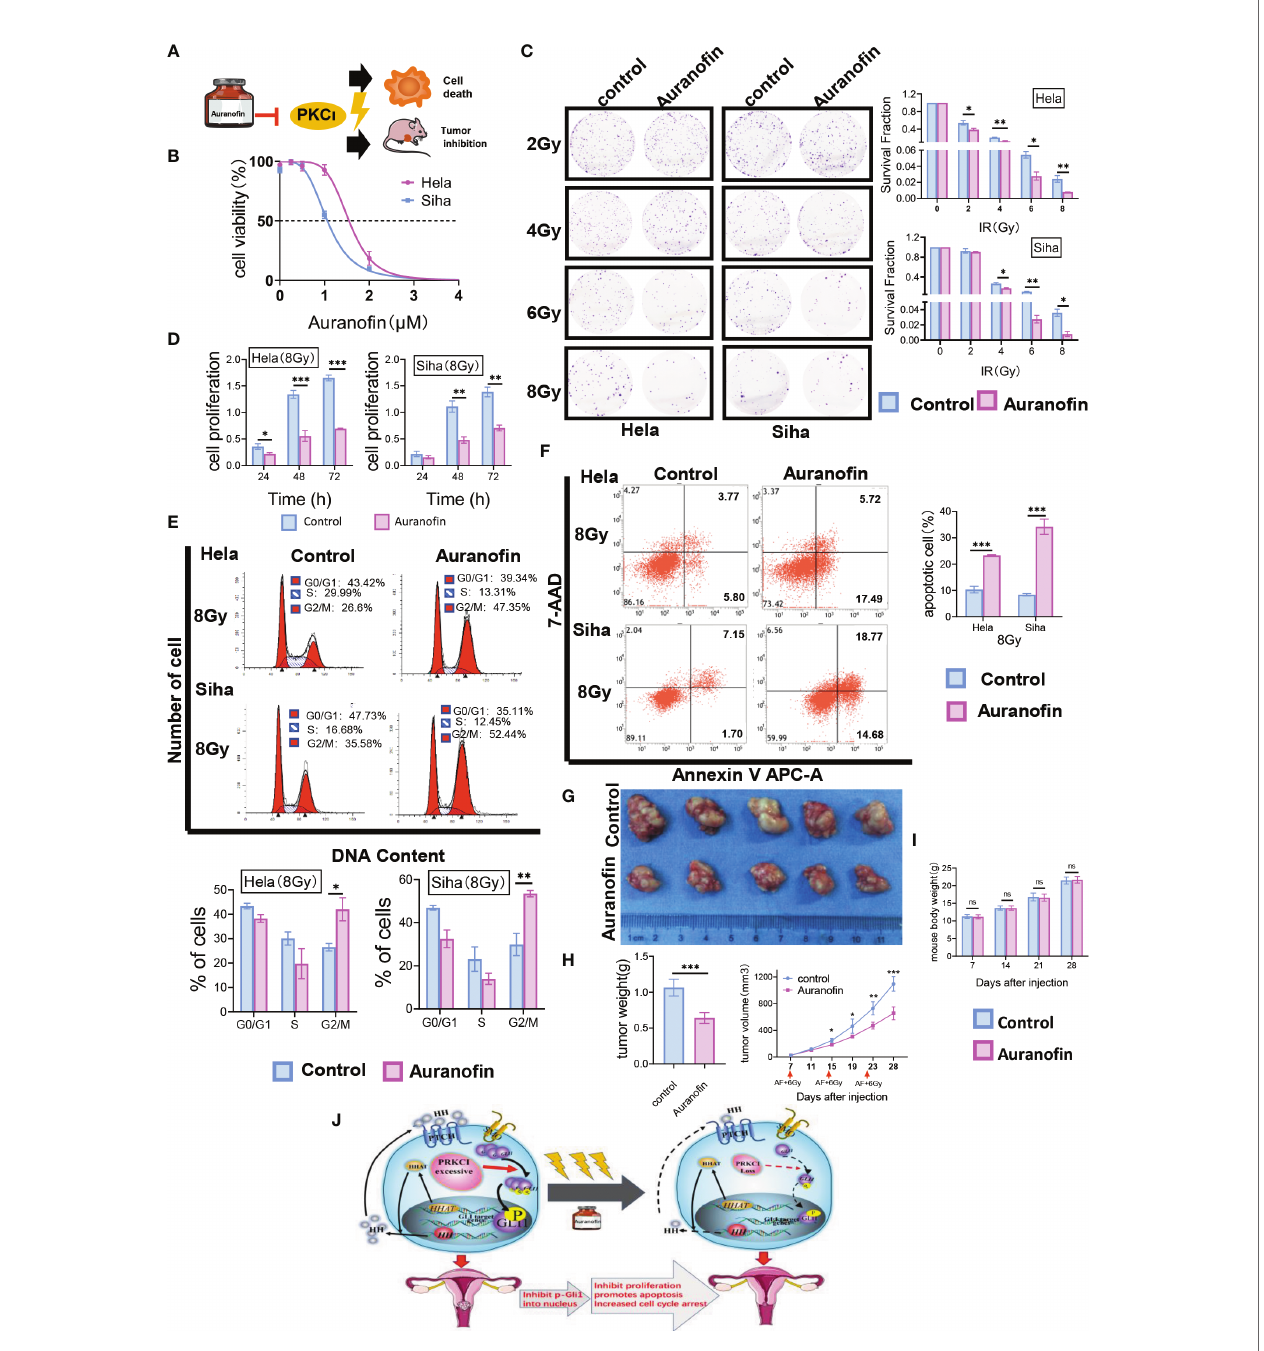
FIGURE 7 | AF, a selective inhibitor of PKC i , affected radiosensitivity in CC cells in vitro and in vivo . (A) Work fl ow for AF-mediated radiosensitivity of CC in vitro and in vivo . (B) Representative IC50 curves calculated for AF in HeLa and SiHa cells are shown. (C) In colony formation assays, AF affected the proliferation of HeLa and SiHa cells treated with radiotherapy in a dose-dependent manner. (D) The cell viability of AF-treated HeLa and SiHa cells after radiotherapy at 8 Gy by CCK-8 assays. (E) AF-induced G2/M- phase cell cycle arrest with radiotherapy. (F) AF increased apoptosis of HeLa and SiHa cells treated with radiotherapy. (G) Nude mouse models were treated by intraperitoneal injection with AF or 0.1% DMSO before irradiation. (H) The xenograft weights and volumes were measured (n = 5/group). (I) Mice from two groups (AF group and control group, 5 mice per group) were weighed during the course of treatments. (J) A cartoon model indicating the role of PRKCI as an oncogene regulates radiosensitivity by modulating GLI1 relocalization and phosphorylation in CC via the Hh/GLI1 pathway. Data are shown as the mean from three independent experiments. *p < 0.05; **p < 0.01; ***p < 0.001 by multiple t-tests (C, D, G, I) , by unpaired t-tests (E, F, H) ns,not signi fi cant. AF, aurano fi n; CC, cervical cancer; IC50, half-maximal inhibitory concentration; CCK-8, Cell Counting Kit-8; DMSO, dimethyl sulfoxide. ns, not signi fi